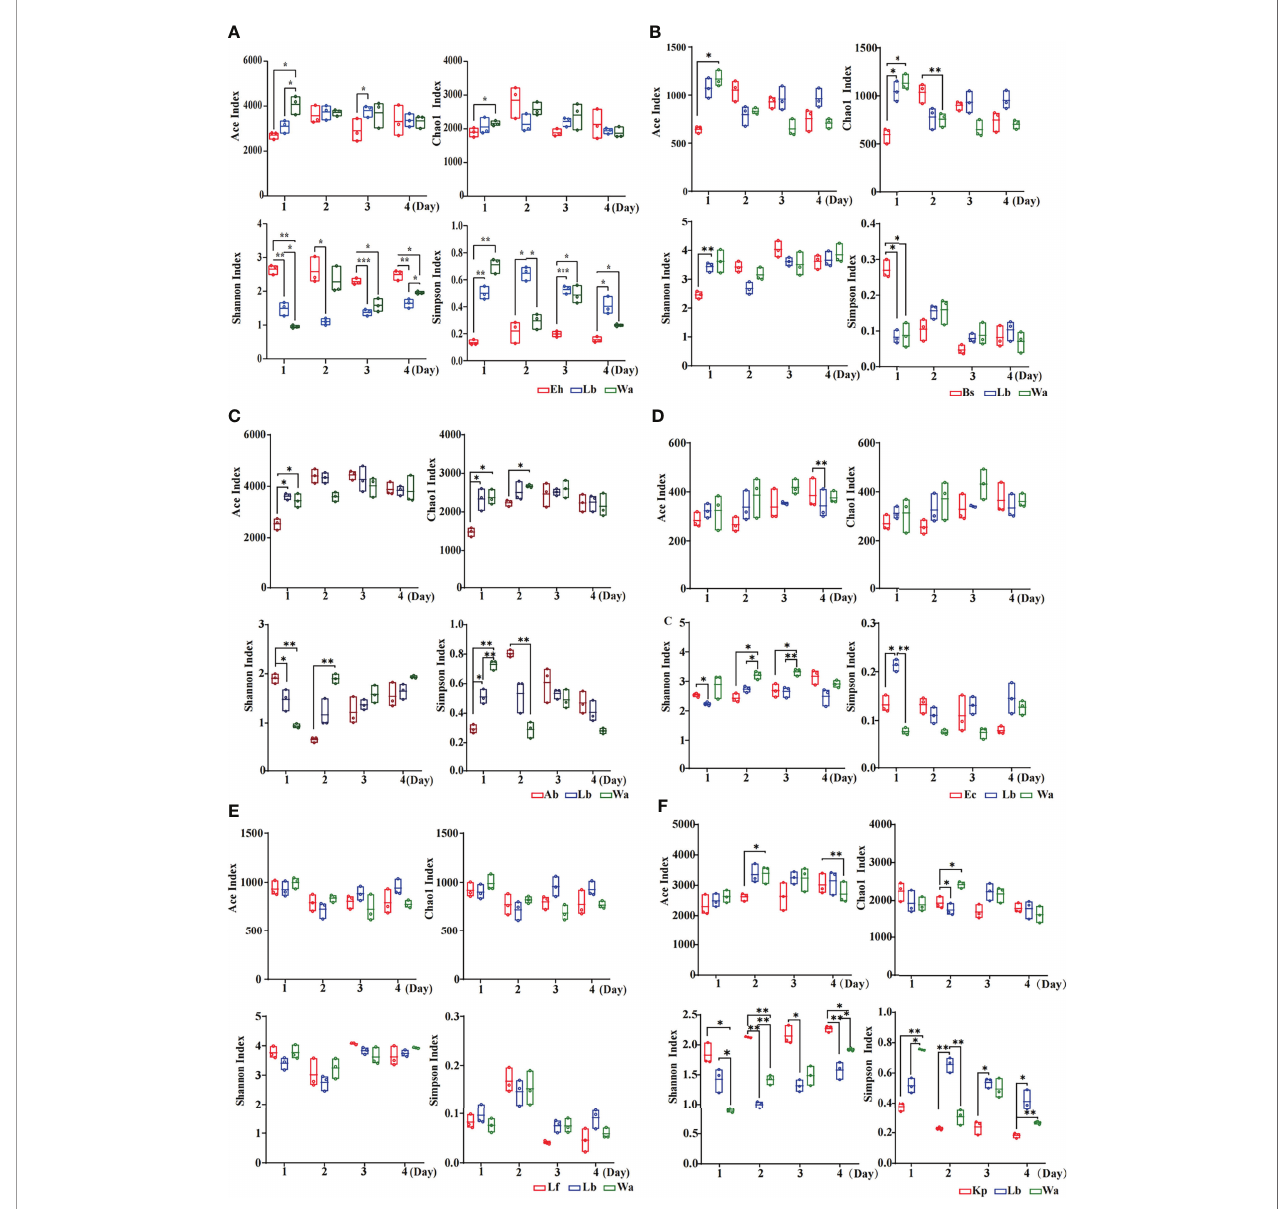
FIGURE 2 | Effects of “ bene fi cial bacteria ” in the guts of house fl y larvae on the intestinal diversity index of larvae. Eh, Enterobacter hormaechei ; Ab, Acinetobacter bereziniae ; Bs, Bacillus safensis ; Ec, Enterobacter cloacae ; Lf, Lysinibacillus fusiformis ; Kp, Klebsiella pneumoniae . Wa, sterile water, blank control group; Lb, Luria- Bertani liquid medium, negative control group; Day 1, Day 2, Day 3, Day 4: the developmental period of house fl y larvae. *p < 0.05, **p < 0.01, ***p <